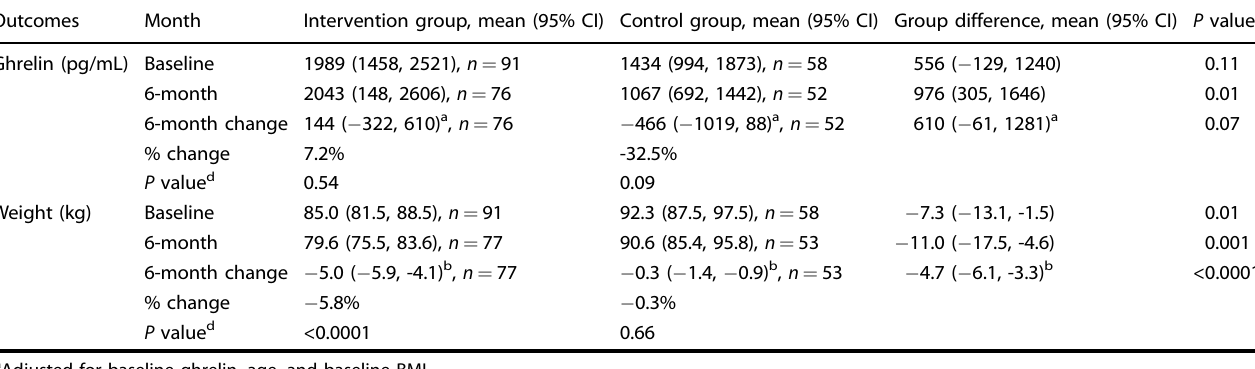
Table 3. Baseline, 6-month, and change in ghrelin levels and weight by randomization group. Outcomes